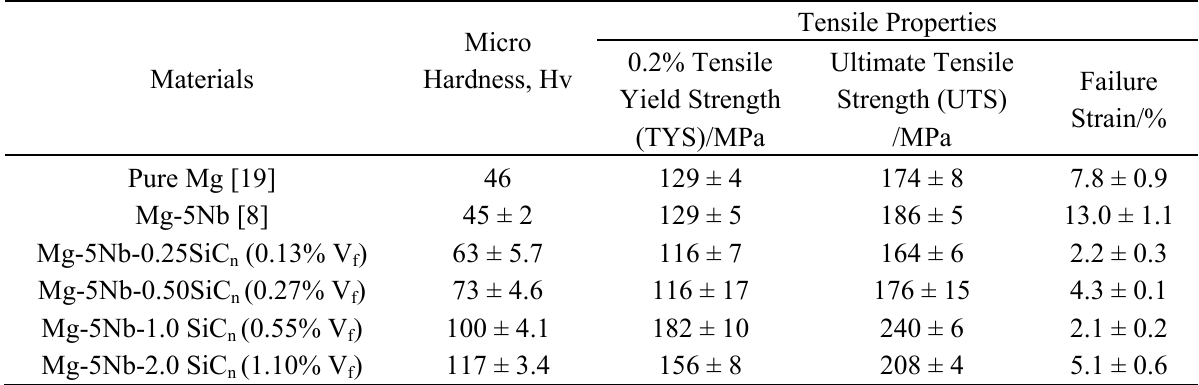
composites with varying SiC n